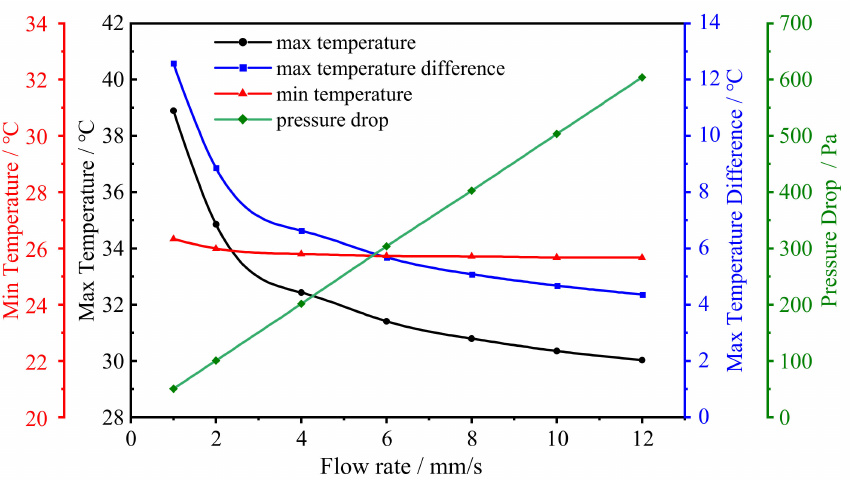
Figure 10. Relationship between the flow rate of the coolant and the MAT, MIT, and MATD of the cell, as well as the pressure drop of the